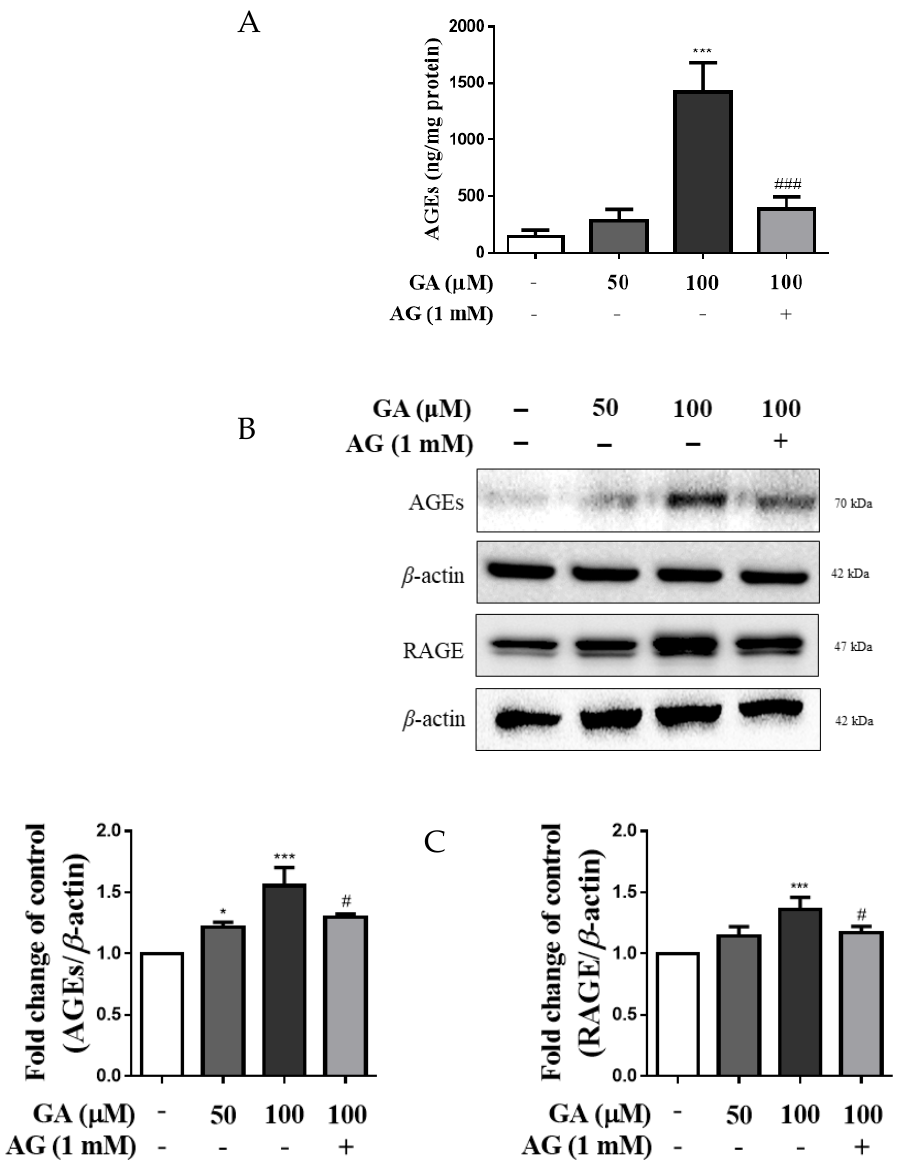
Figure 2. GA induced accumulation of AGEs and expression of RAGE and AGEs in mesangial cells. ( A ) AGE levels were determined using an ELISA kit. Cells were treated with GA or AG and incubated for 24 h. The quantity of AGEs was measured by comparing with the AGE-BSA standard curve. ( B ) Western blot analysis of RAGE and AGEs. ( C ) Quantification of RAGE and AGE expression and internal control by β -actin. Data are expressed as the mean ± SD ( n = 3). * p < 0.05 and *** p < 0.001 vs. untreated group, # p < 0.05 and ### p < 0.001 vs. 100 μM GA. GA, glycolaldehyde; AGEs, advanced glycation end products; RAGE, receptor for advanced glycation end products.